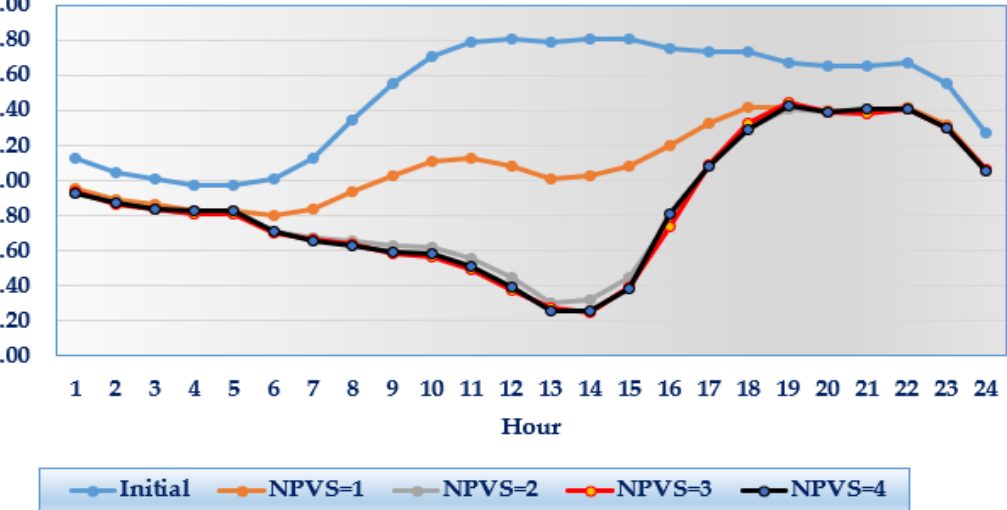
Figure 9. Hourly power losses with varying the number of installed devices compared to the initial case for IEEE 33-feeder.